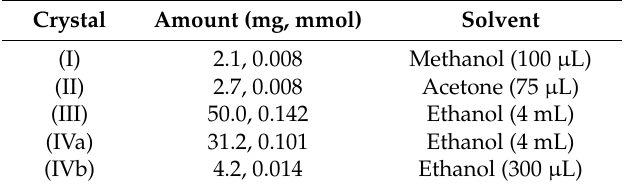
Table 1. Crystallization 1 of 1,3,3-Trimethylindolino-benzopyrylospiran (I), 1,3,3- Trimethylindolinonaphthospirooxaxine (II), 1-(2-Hydroxyethyl)-3,3-dimethylindolino-6 (cid:48) - nitrobenzopyrylospiran (III), 1,3,3-Trimethylindolino-8 (cid:48) -methoxybenzopyrylospiran